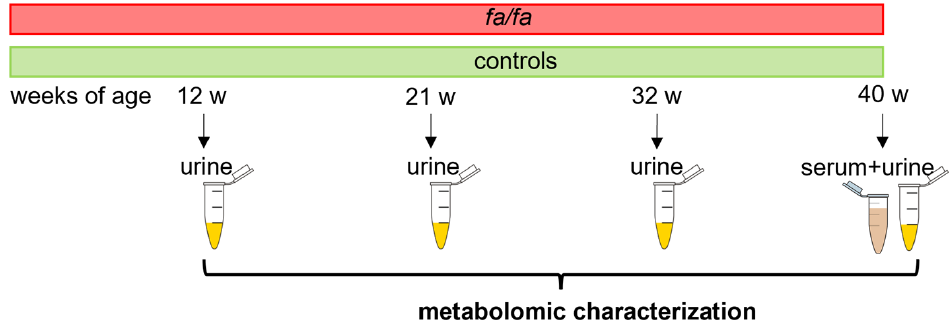
Figure 1. Experimental design.